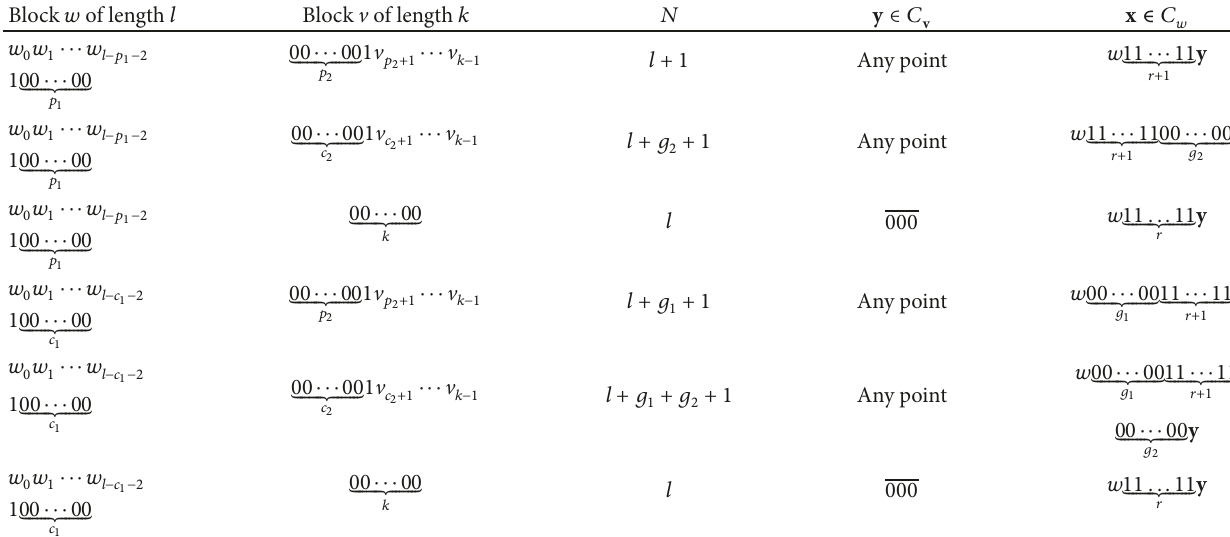
Table 1: Cases for blocks 𝑤 and V